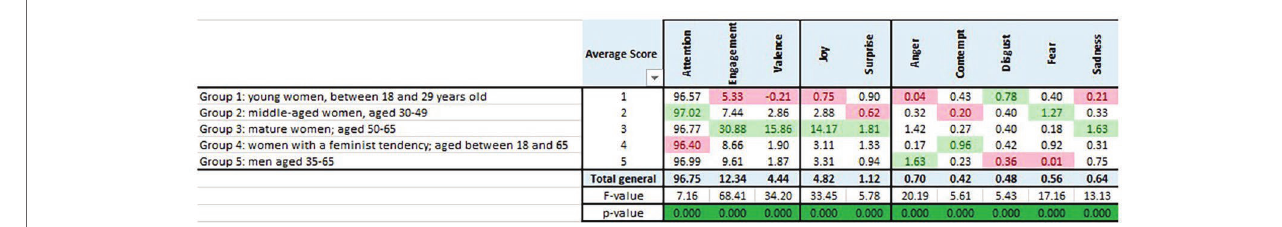
FIGURE 4 | Inferential analysis per group.